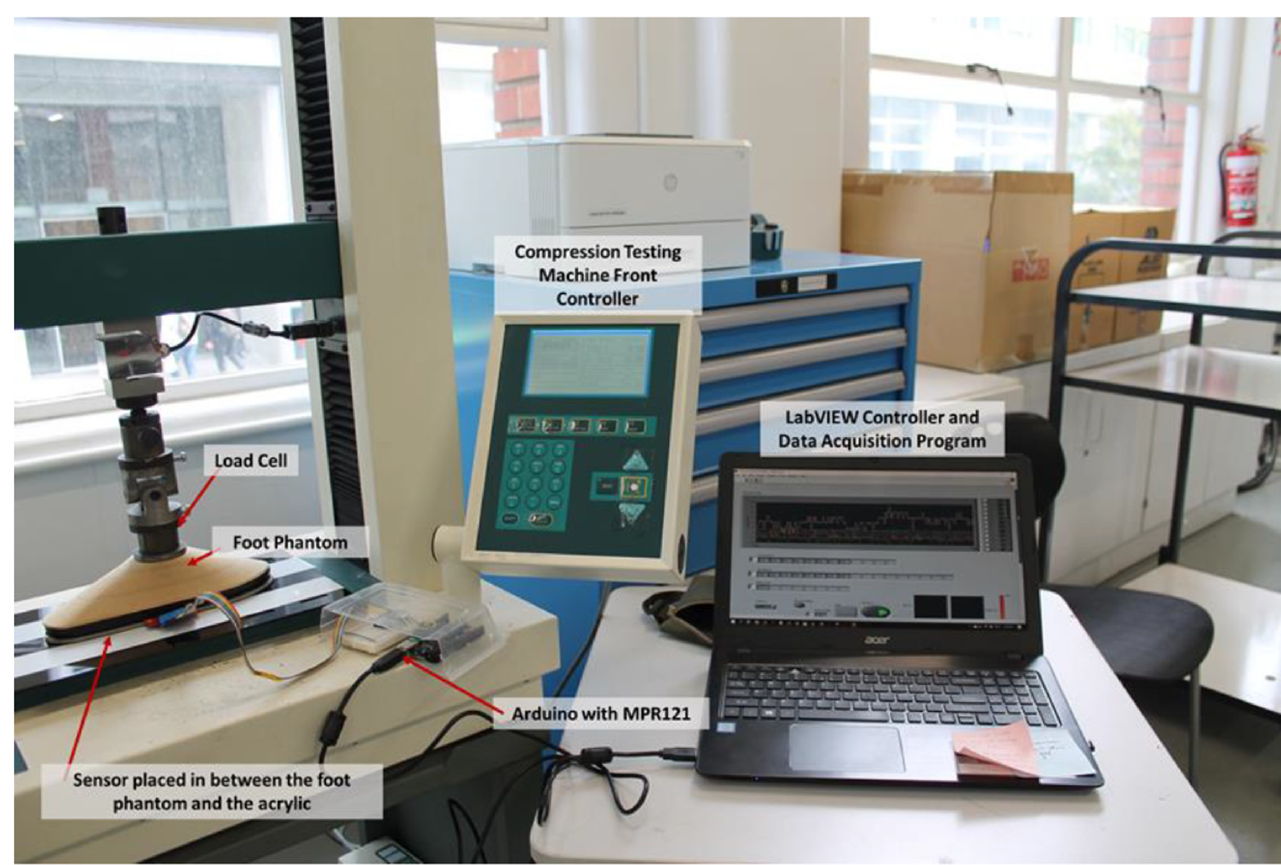
Figure 10. Testing Setup for VT2.